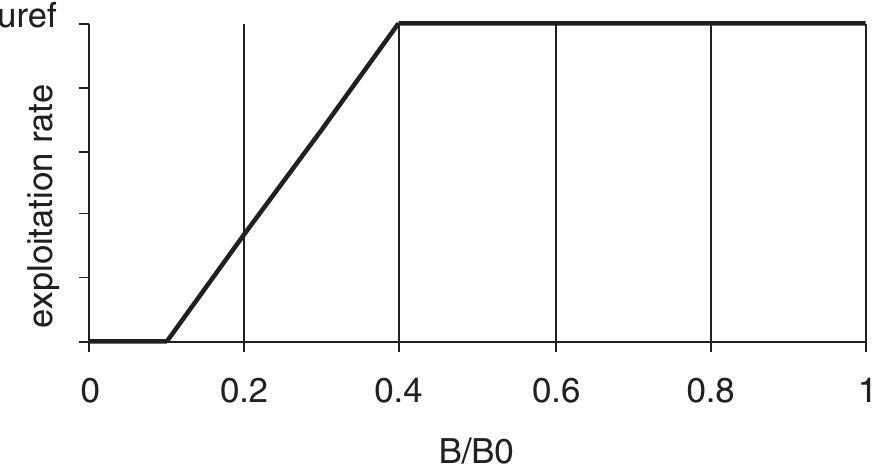
F IG . 1. – The relationship between stock size and target exploitation rate, slightly adapted from the rule used by the Pacific Fisheries Man- agement Council. Uref is the target exploitation rate, B is the current estimated stock size and B0 is the estimated unfished equilibrium stock size. In some applications exploitation rates are instantaneous fishing mortality rates, in other applications they are catch divided by